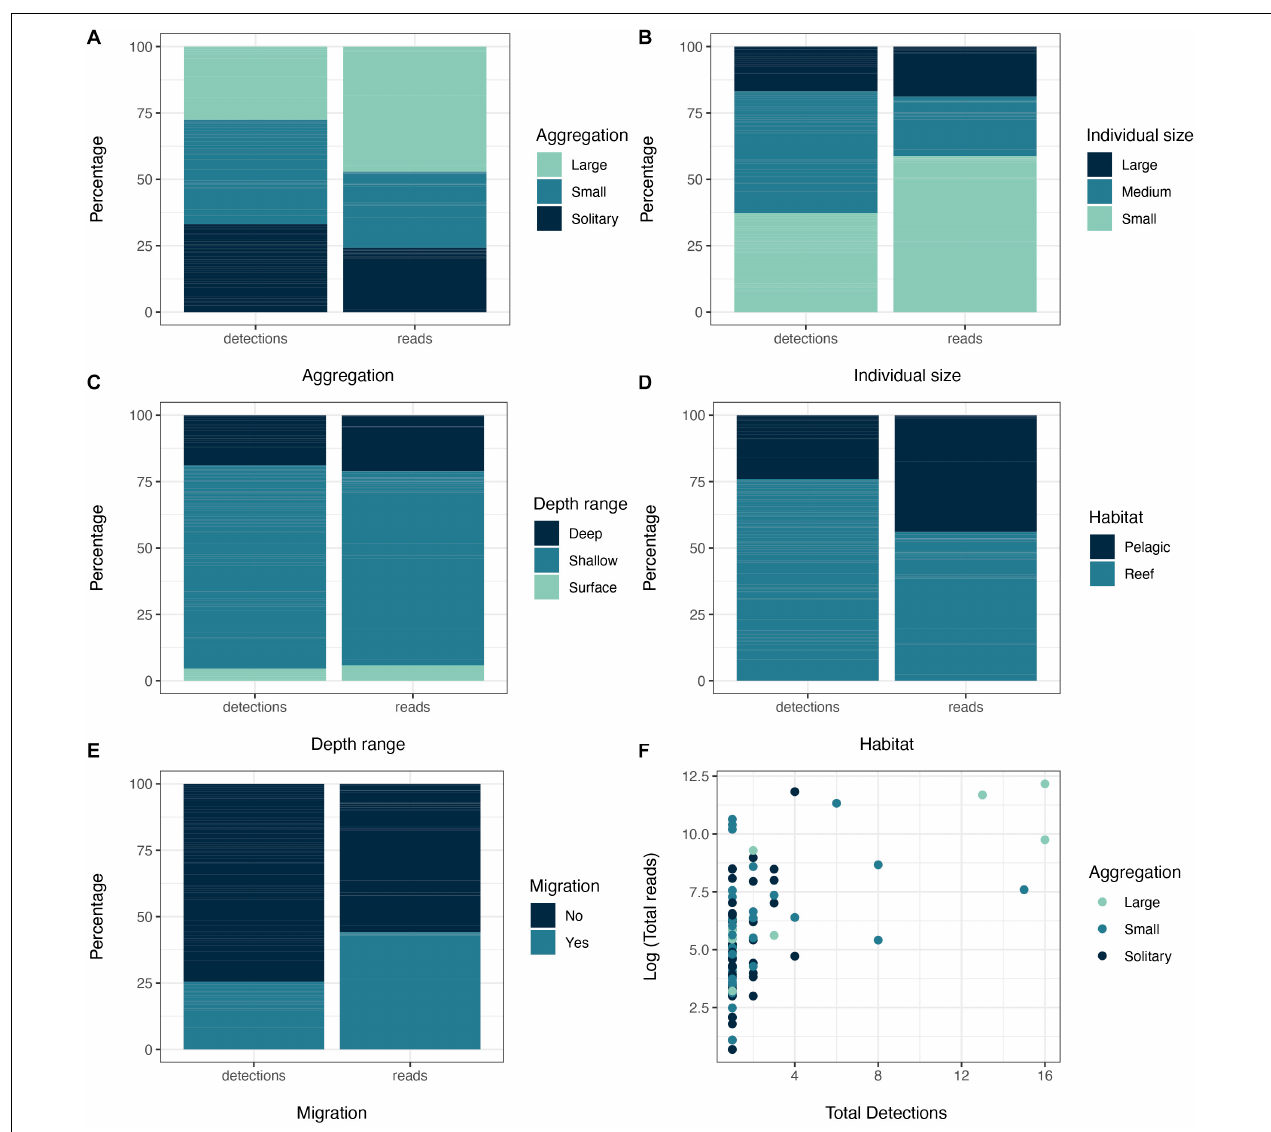
FIGURE 5 | Percentage of total detections and total reads associated to specific categories within the studied fish features: (A) Aggregation behavior, (B) Individual size, (C) Depth range, (D) Habitat, and (E) Migration. (F) Relationship between total reads (log transformed) and total detections colored by the aggregation behavior of the represented MOTUs (fish